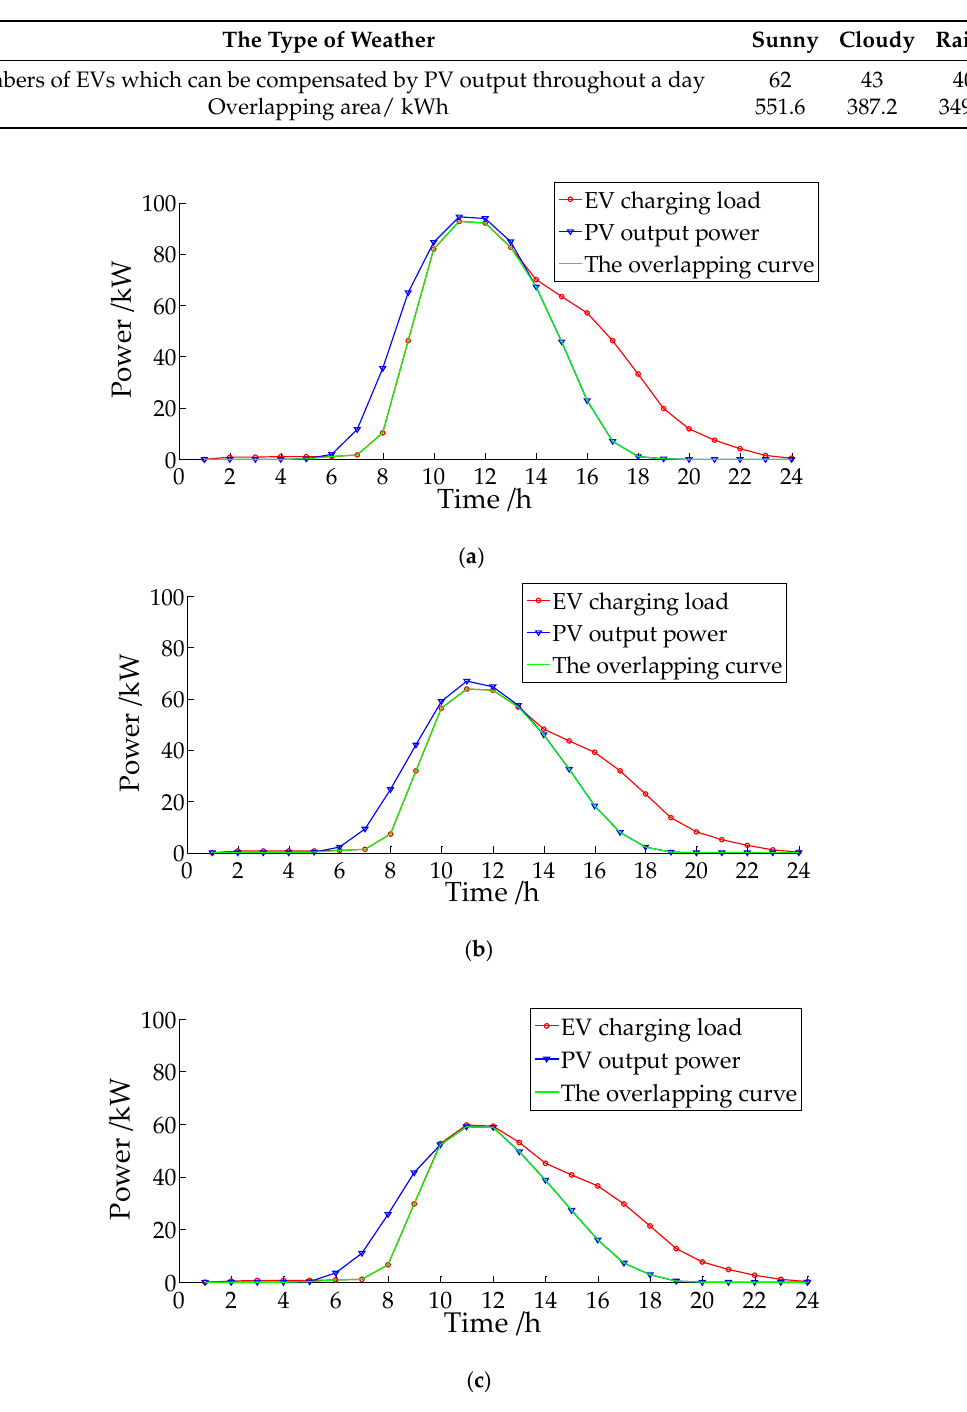
t=t+ 1 Figure 10. Flow chart of optimal charging method. 6. Case Study and Discussion